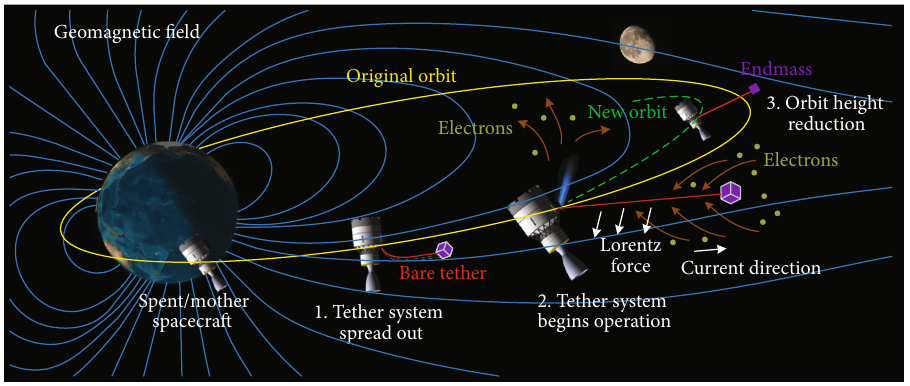
Figure 1: Working principle of the bare electrodynamic tether